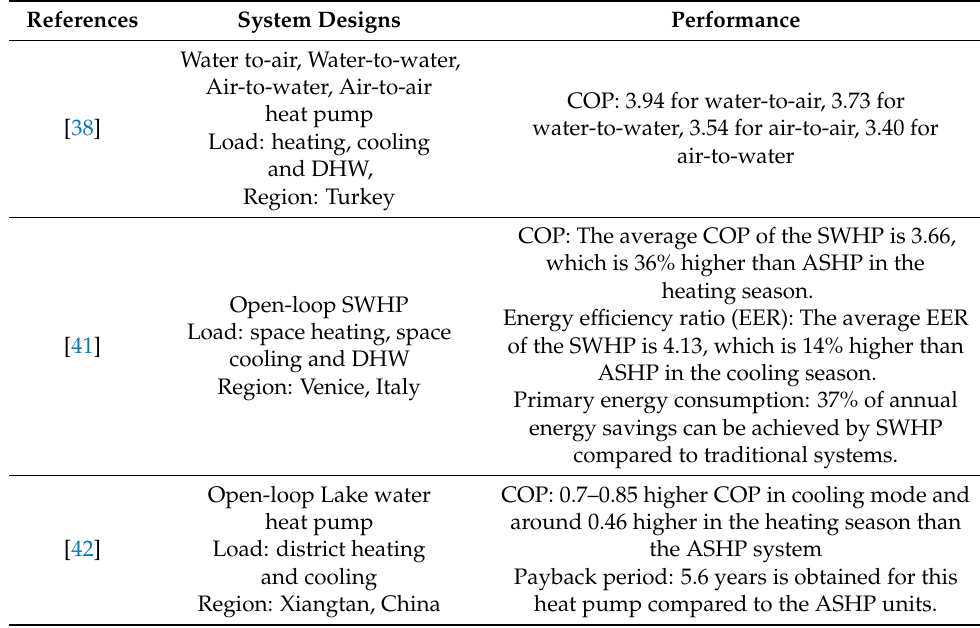
Table 2. Summary of studies of WSHP